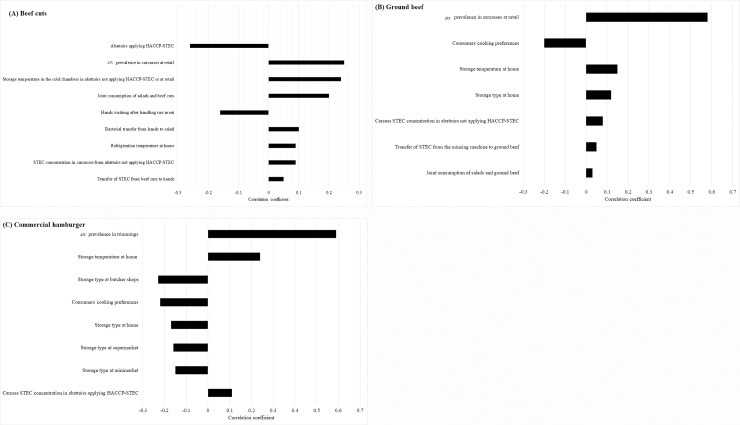
(A-C). Sensitivity analysis of model inputs on the probability of developing HUS.